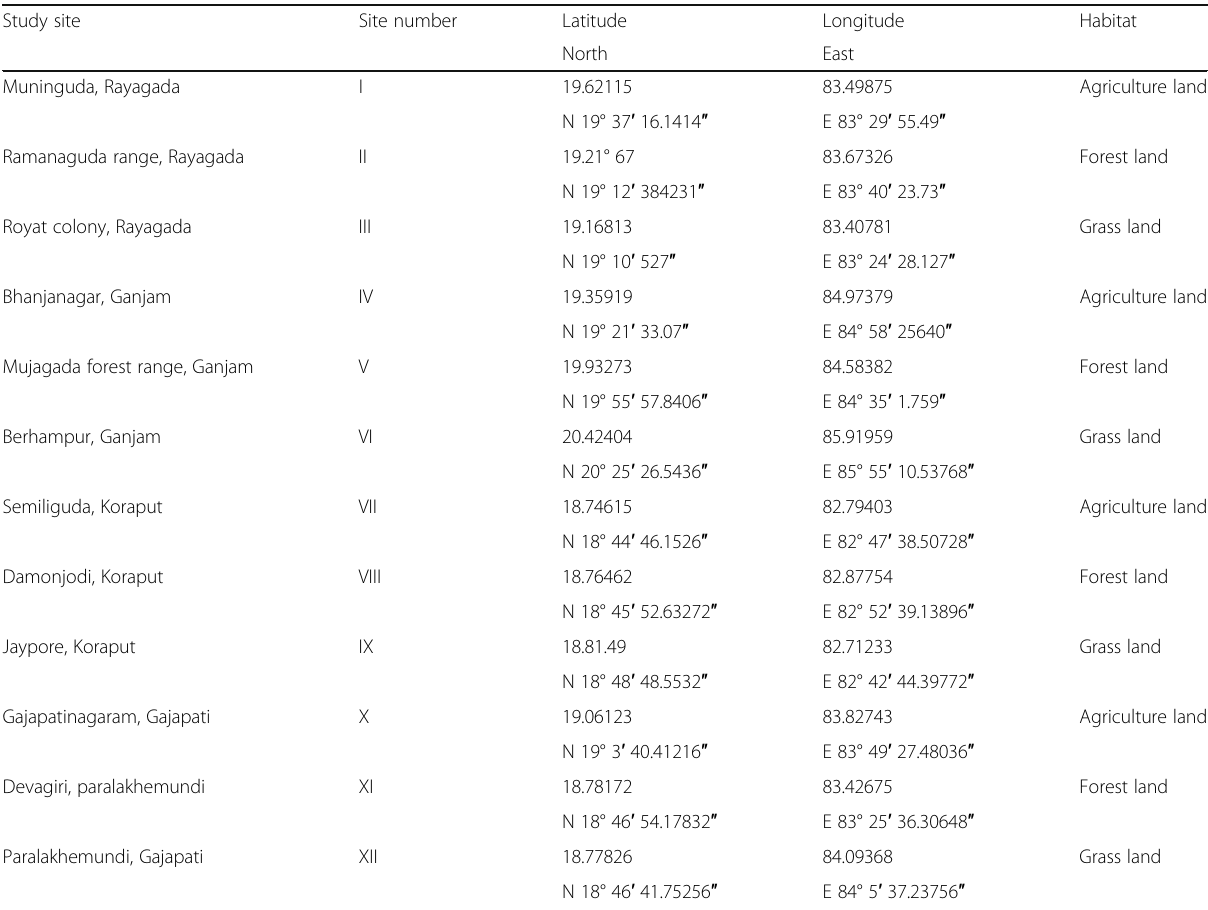
Table 1 Description of study sites with latitude, longitude, and type of habitat Study